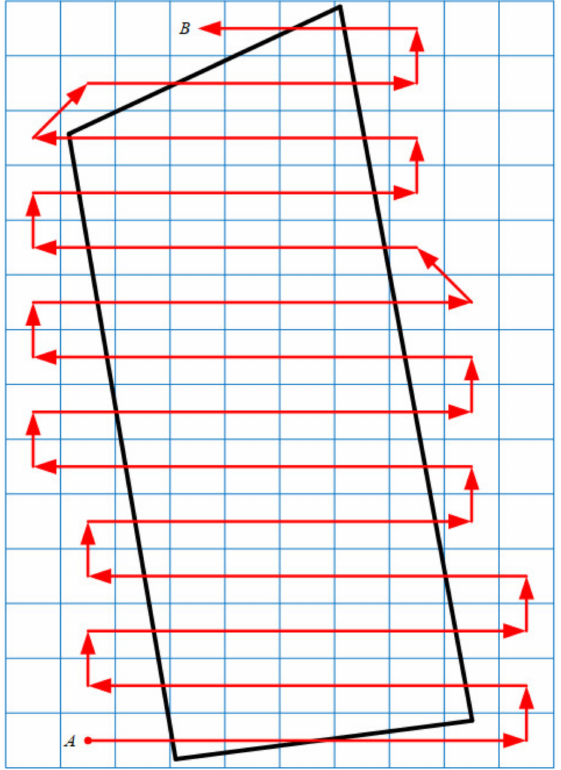
Figure 9. Schematic diagram of the common grid method. The red lines with arrows represent the route. The black polygon represents the operation region. Any grids that overlap with the operation region need to be